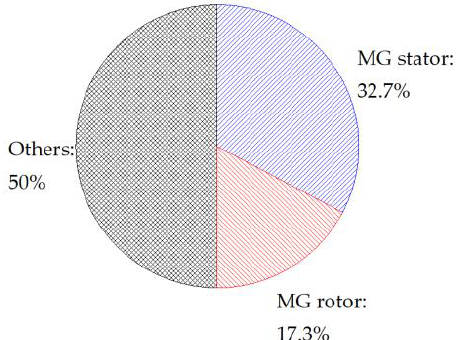
Figure 3. JF-10D generator weight distribution diagram.